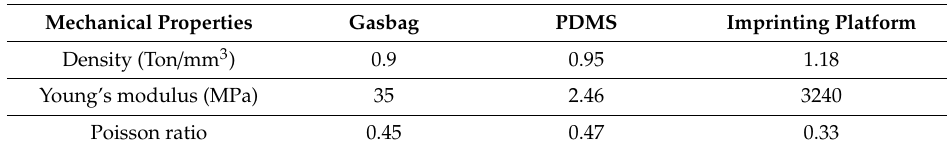
Table 1. Material parameters for Abaqus software simulation after testing the mechanical properties of the material.